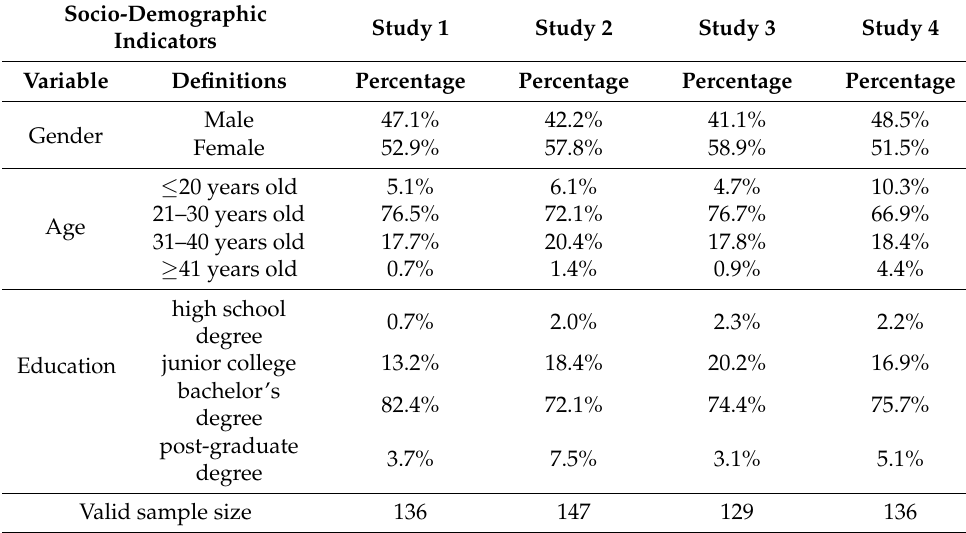
Table 1. Socio-demographics of consumers in Study